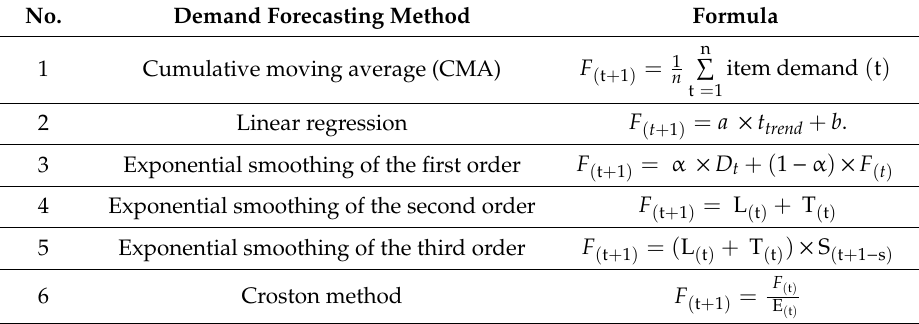
Table 2. Demand forecasting methods (own elaboration based on